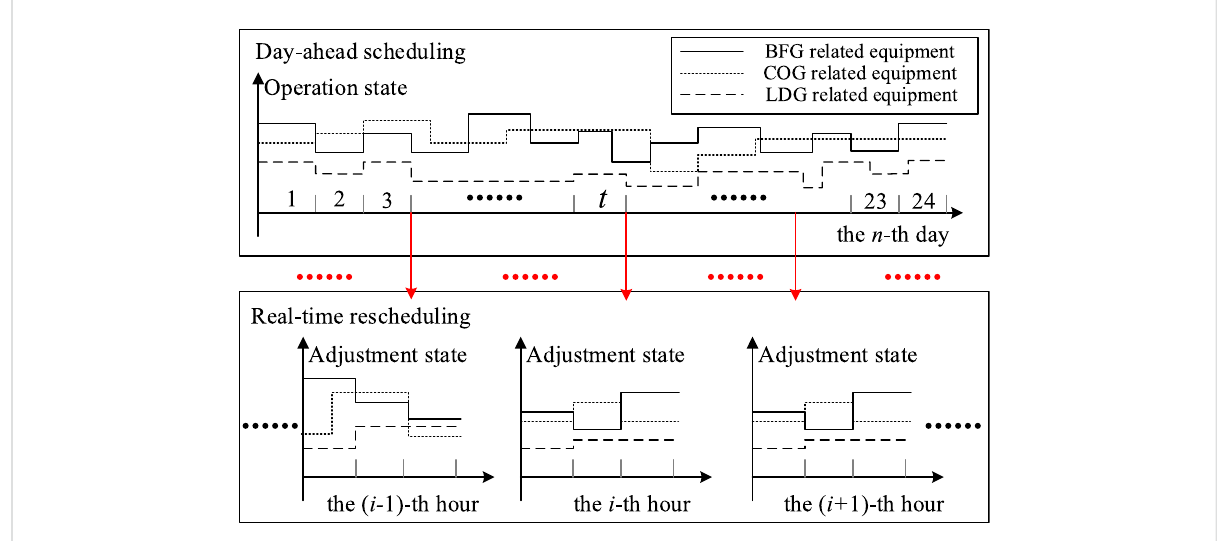
FIGURE 2 Schematic diagram of DRO